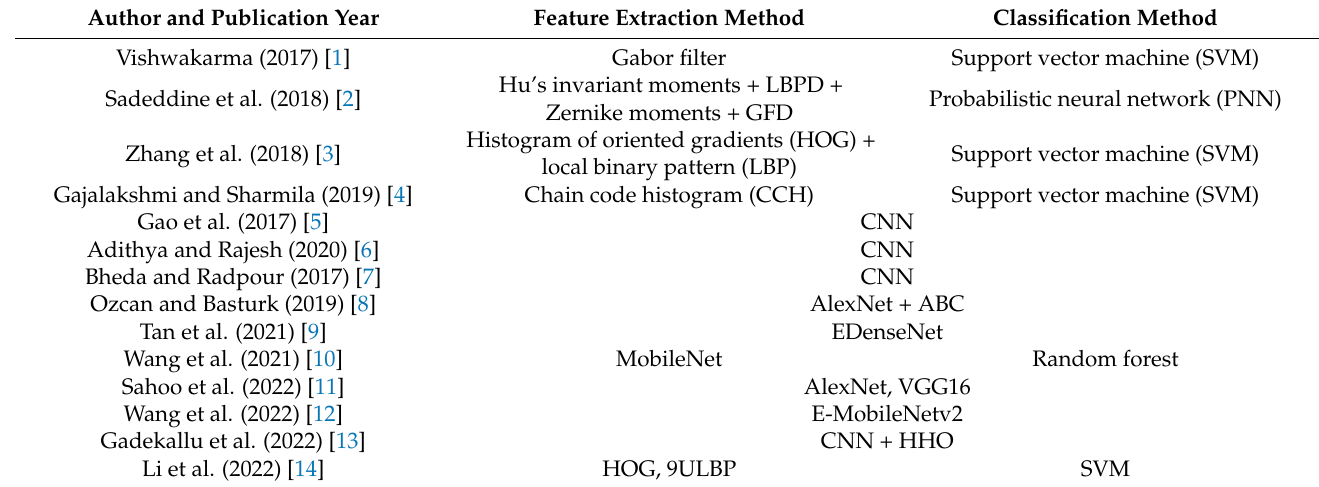
Table 1. Summary of related